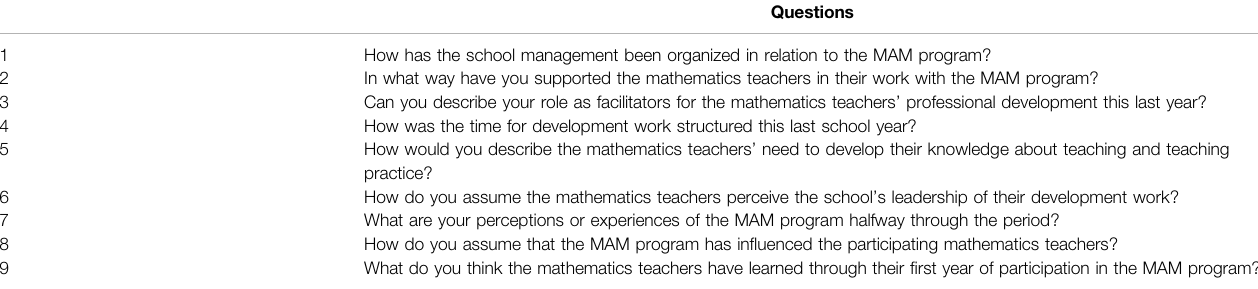
TABLE 2 | Structure of the focus-group interview guide for the school management, spring 2020.